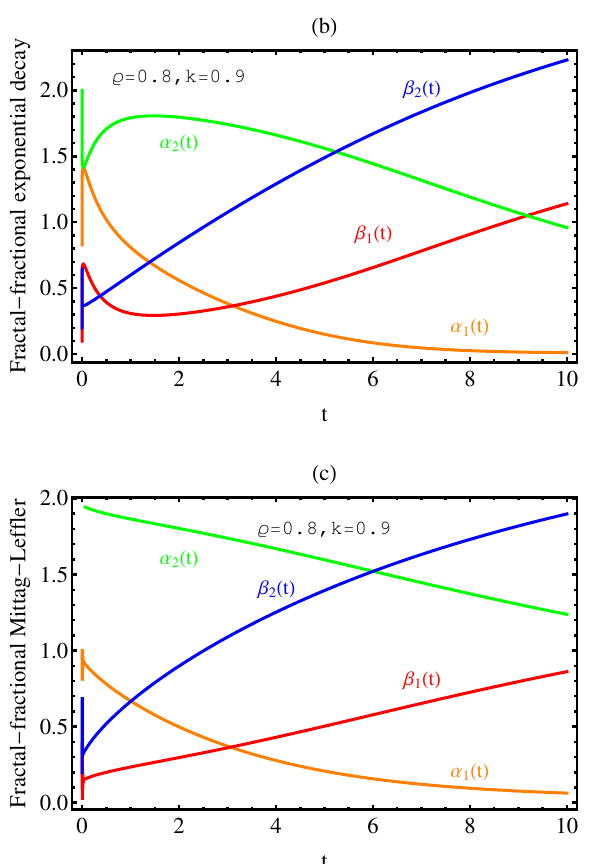
Figure 4. The numerical solutions of the fractal–fractional Michaelis-Menten enzymatic reaction for (cid:36) = 0.8, k = 0.9, δ = 1, γ = 2, σ = 1, and h = 0.003. ( a ) The numerical solutions of Equations (36)–(39) based on power-law kernel; ( b ) The numerical solutions of Equations (62)–(65) based on exponential decay kernel; ( c ) The numerical solutions of Equations (82)–(85) based on Mittag-Leffler kernel (orange line: α 1 ( t ) ; red line: β 1 ( t ) ; green line: α 2 ( t ) ; blue line: β 2 ( t ))